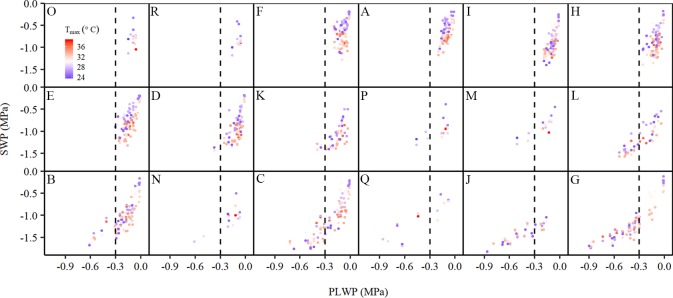
Relationship between stem water potential and predawn leaf water potential (PLWP) along a temperature gradient [Tmax, from 23.8°C (blue) to 38.9°C (red)] collected during the 2015 and 2018 seasons for each experimental plot (n=1,061). The letters correspond to the plots as specified in
Table 1
. The vertical dotted line is drawn for reference at −0.3 MPa PLWP.